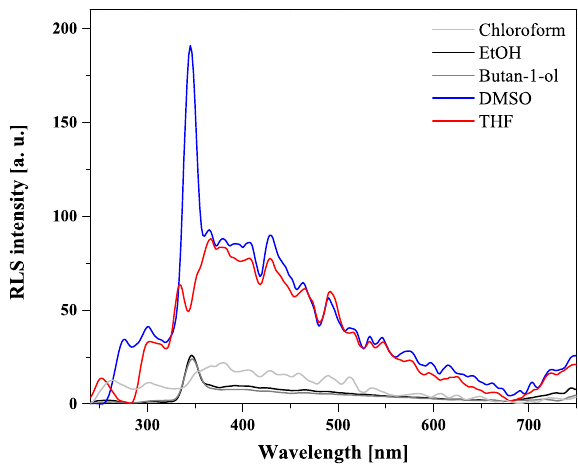
Figure 7. RLS spectra measured for NTBD in various solvents.